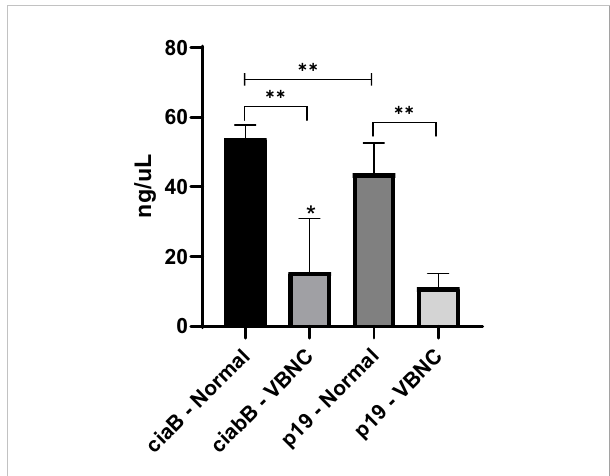
FIGURE 4 Quantitative analysis of ciaB and p19 transcript regulation in normal and VBNC forms of 27 strains of C. jejuni . *p < 0.05 within the same group; **p < 0.01 between groups, using one-way ANOVA. Error bars indicate the standard deviation for the means obtained by eight replicates by strain.